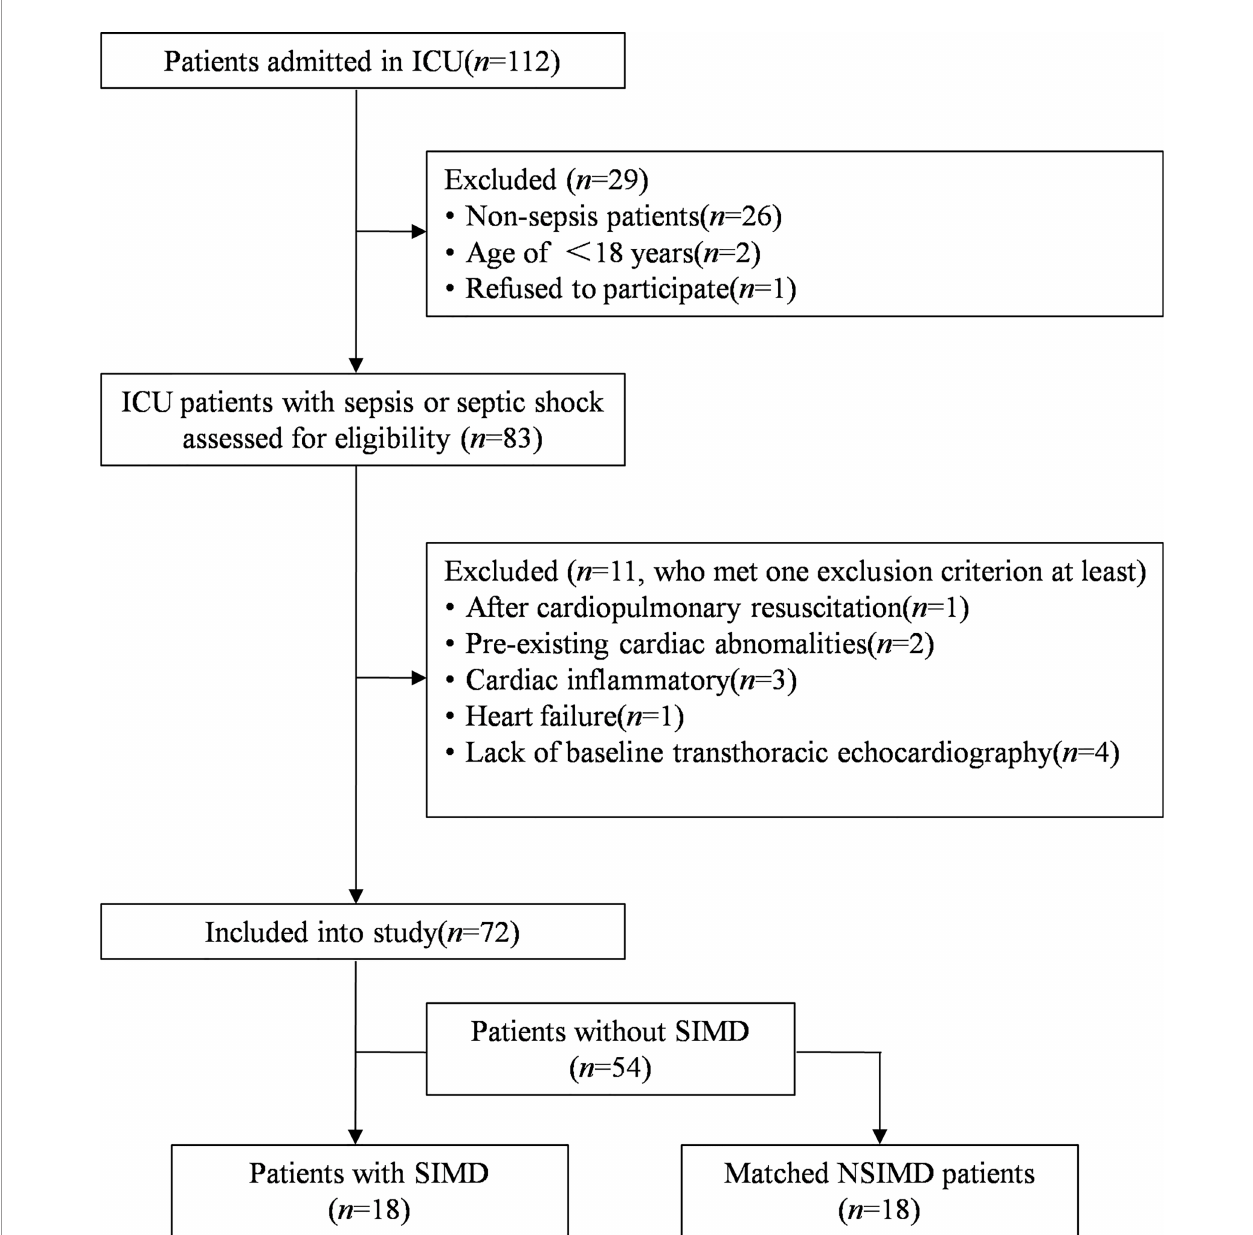
FIGURE 1 | Flowchart of this matched case – control study. SIMD, sepsis-induced myocardial dysfunction; NSIMD,